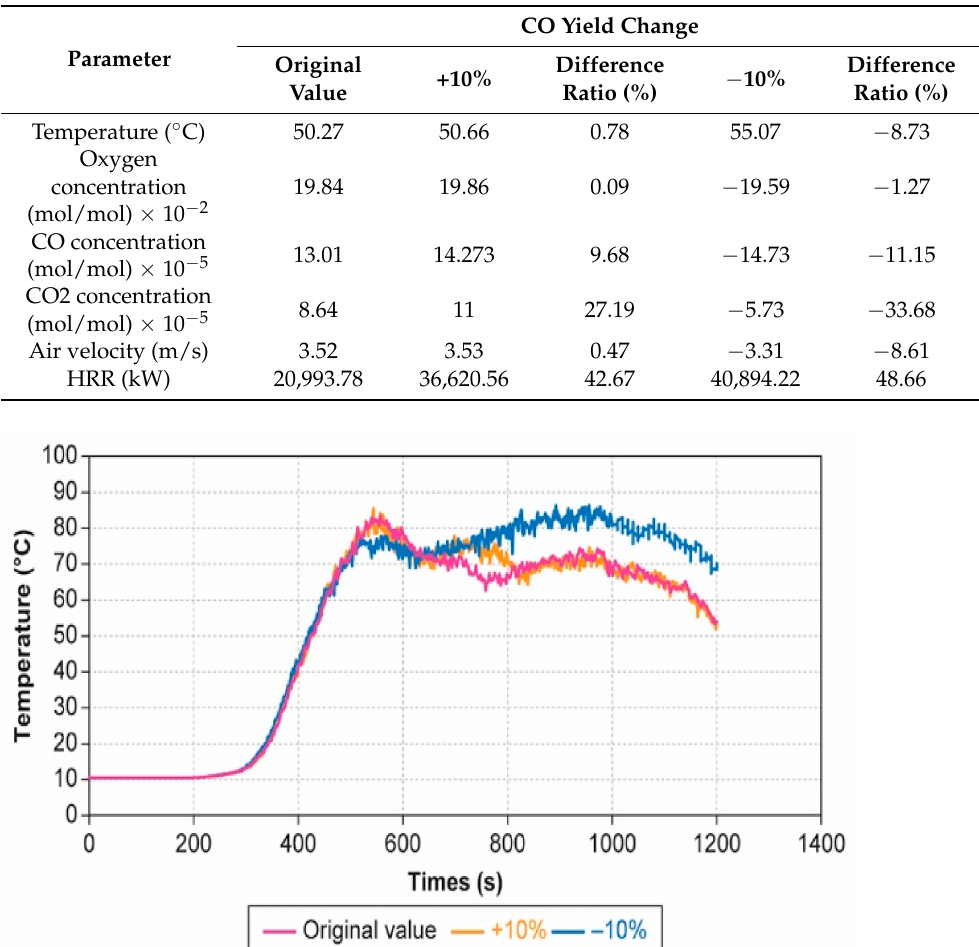
Figure 12. CO yield effects on gas temperature, 458 m downstream and 5.1 m above road surface.